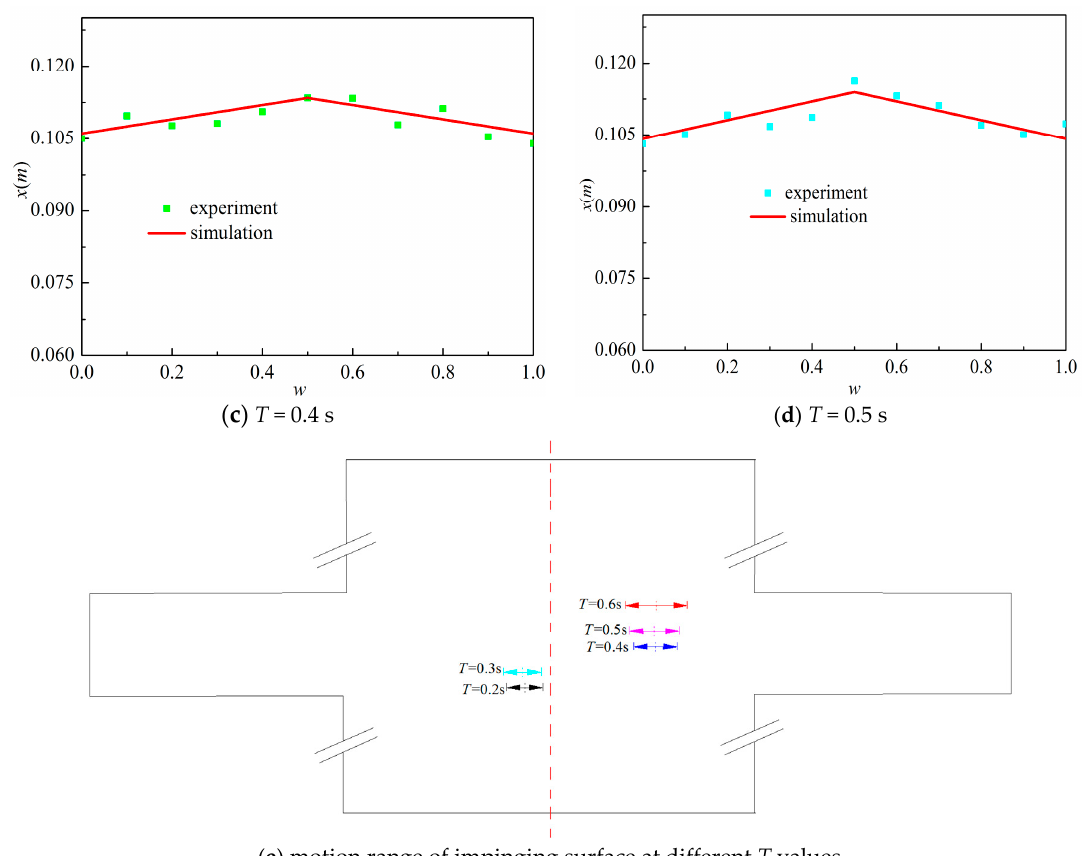
Figure 12. Effect of period on the position of the impinging surface, as determined by PIV and CFD for a sinusoidal inlet velocity at u m = 1.25 m/s, A = 0.25 m/s, L/D = 4 and ∆ (cid:2030) = T/2 in one period.